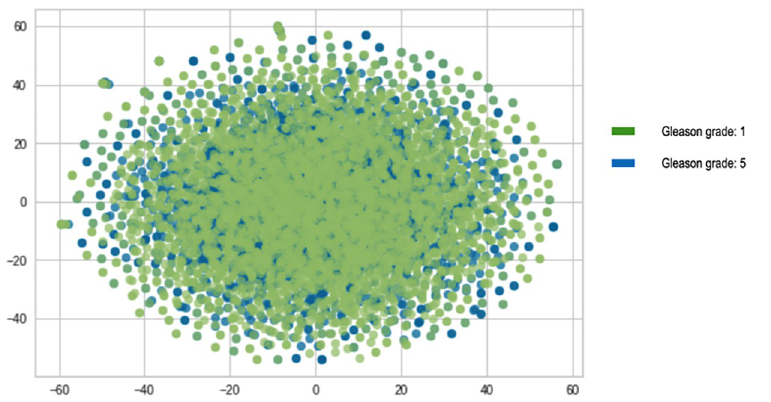
Fig 6. Visualisation of TF-IDF kmers for BRCA 2 kmers .